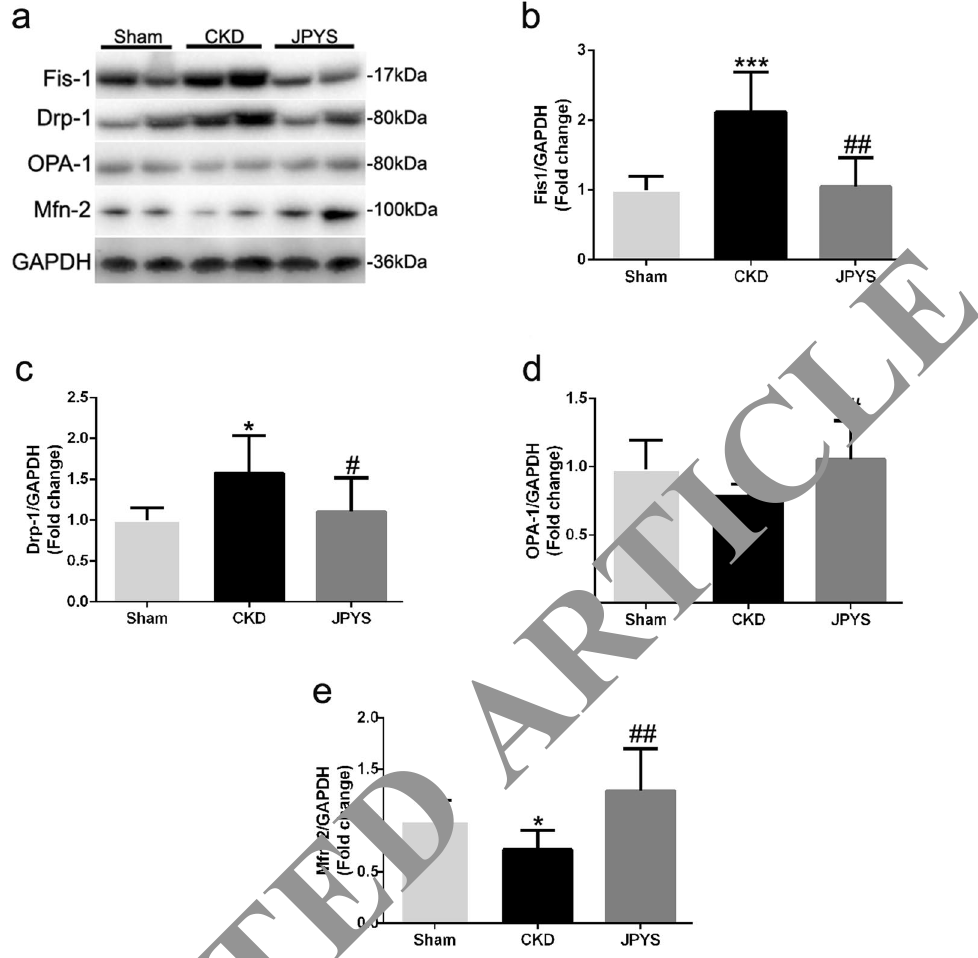
Figure 7. Effect of JPYS decoction on skeletal muscle mitochondrial dynamics in 5/6 nephrectomised rats. ( a ) Representative Western blot images of Fis-1, Drp1, Opa1 and Mfn2 protein expression. Quantification of ( b ) Fis-1, ( c ) Drp1, ( d ) Opa1 and ( e ) Mfn2 protein levels. GAPDH was used as loading control. Data are expressed as Fold change vs. Sham and reported as means ± SD, n = 6 per group, * P < 0.05, *** P < 0.001 between Sham and CKD groups. # P < 0.05, ## P < 0.01 between CKD and JPYS